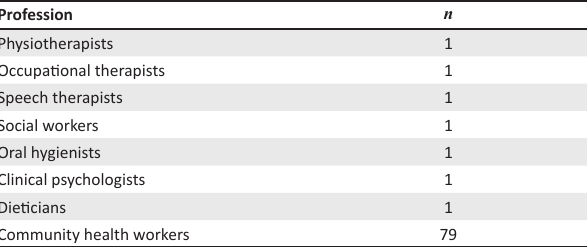
TABLE 3: Participant profile of the two cooperative inquiry groups. Characteristics